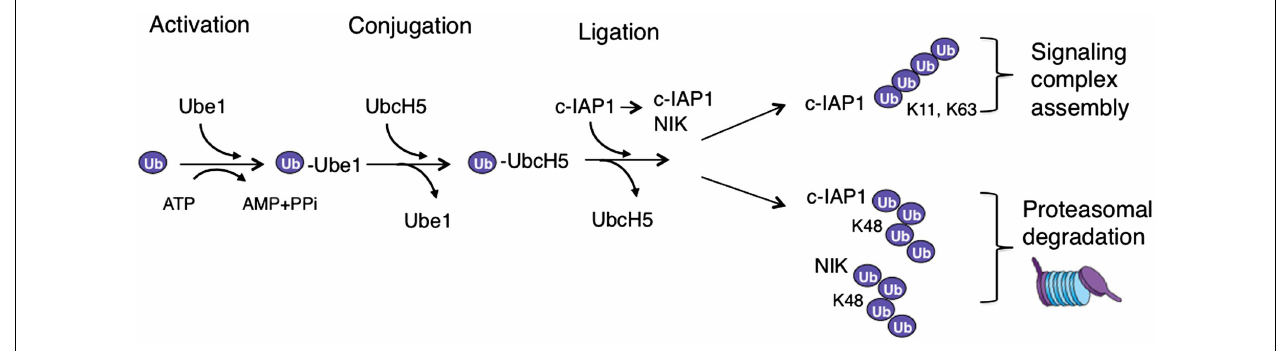
ubiquitin ligation to occur.When polyubiquitin chains are assembled this process is repeated with a lysine (K) residue of the ubiquitin molecule itself serving as a substrate.The assembly of K63- or K11-link polyubiquitin chains on c-IAP1 promotes the formation of signaling complexes, while K48-linked ubiquitination of NIK or c-IAP1 targets them for proteasomal degradation.